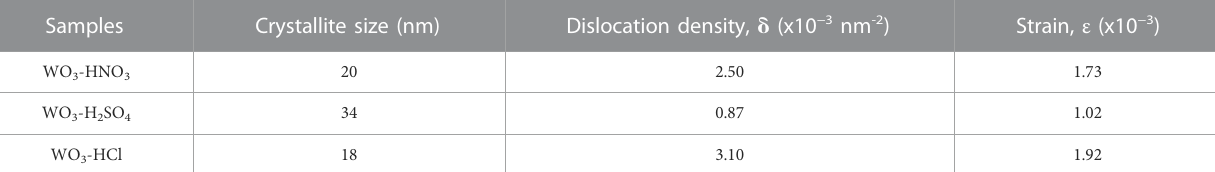
TABLE1Thecrystallitesize,dislocationdensityandstrainofWO 3 -HNO 3 ,WO 3 -H 2 SO 4 andWO 3 -HClsamplescalculatedfromthepeakcorrespondingto(002)crystal plane using Debye-Scherrer equation.